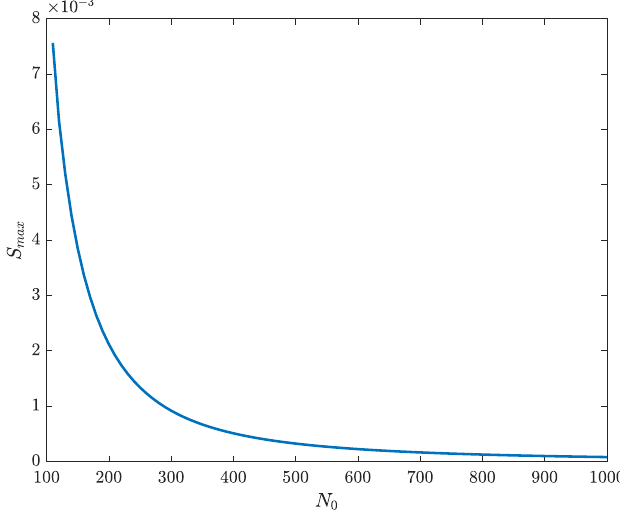
Figure 2. Convergence of the series S kr with respect to N o